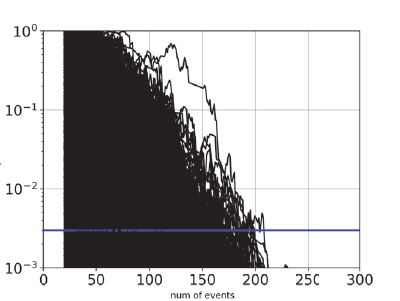
Figure 5: p-value obtained by comparing the HotSpot and Background Xmax distributions for every 10 events for 10,000 results